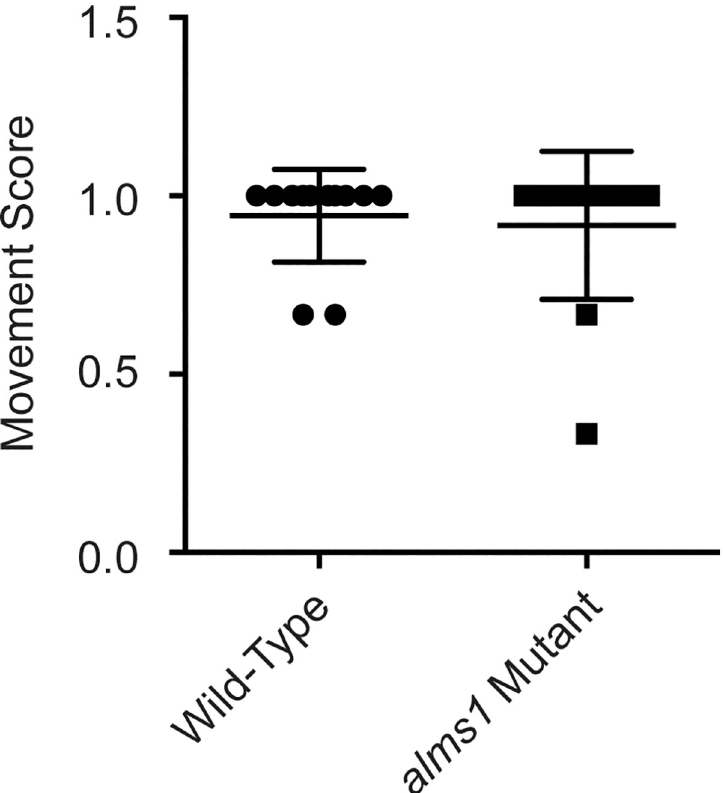
Fig 2. alms1 mutants respond to vibrational stimuli. Quantification of the number of times fish respond to a vibrational stimuli across three times. A score of 1 means a fish responded all three times whereas a score of 0 means a fish never responded. There was no significant difference between the two groups by an unpaired t-test (p = 0.6977), n = 12 fish per group. Individual data points are shown along with the mean and standard deviation of the data.